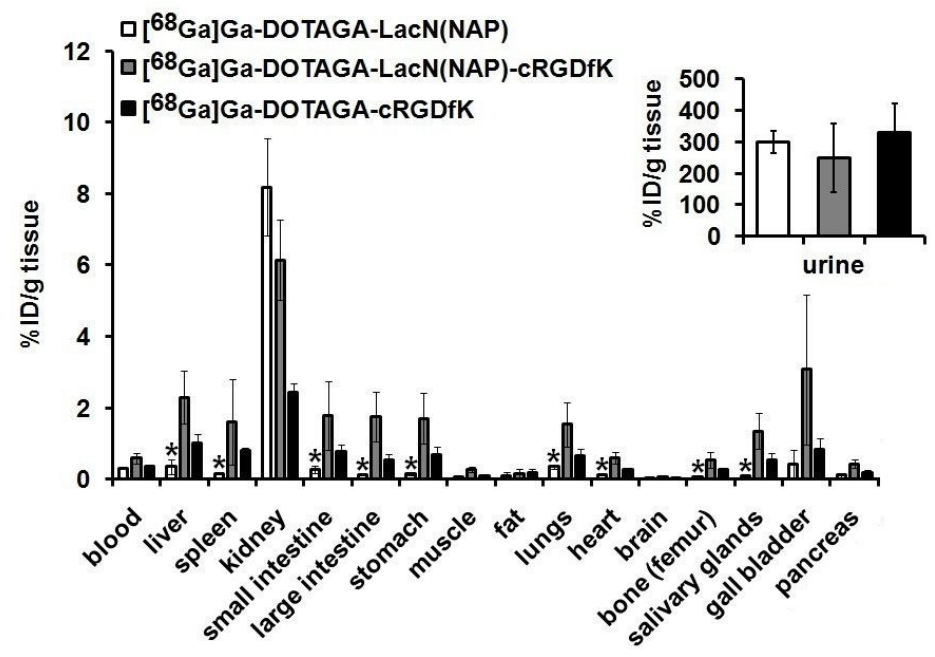
Figure 7. Ex vivo biodistribution of the 68 Ga-labeled DOTAGA-LacN(NAP), DOTAGA-LacN(NAP)- cRGDfK, and DOTAGA-cRGDfK in C57BL/6 mice (n = 5/radiopharmaceutical) 100 min after intra- venous injection of the radiotracers. %ID/g tissue values are presented as mean ± SD. Significance level between the [ 68 Ga]Ga-DOTAGA-LacN(NAP) and the two other investigated radiotracers: p ≤ 0.01 (*).